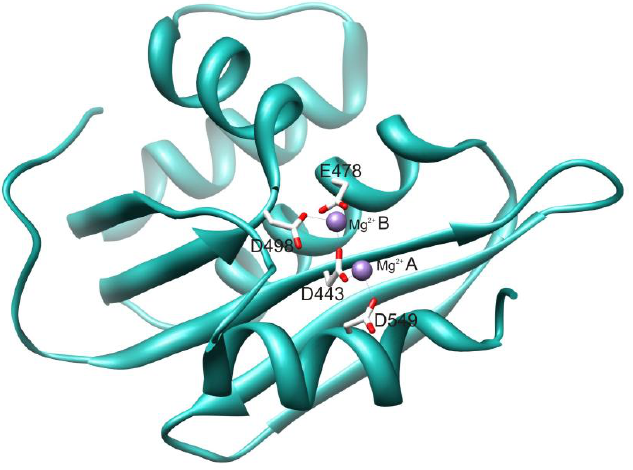
Figure 2. Structure of the RNase H domain of HIV-1 RT. Active site catalytic residues are depicted in stick form and the active site Mg 2+ cations are shown as spheres. The figure is derived from PDB file 3K2P and was drawn using UCSF Chimera software [6].